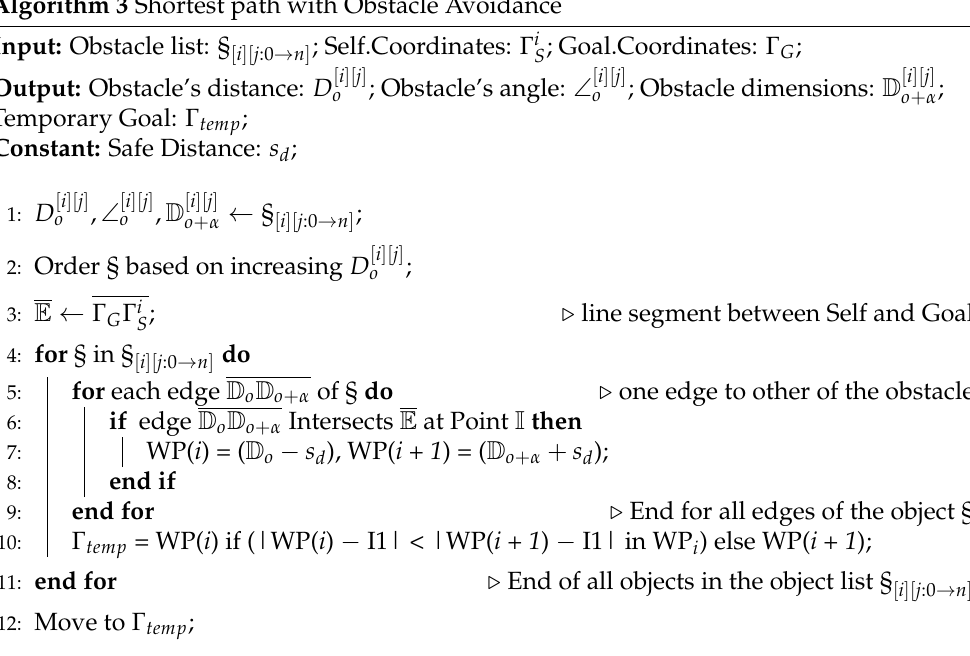
Algorithm 3 Shortest path with Obstacle